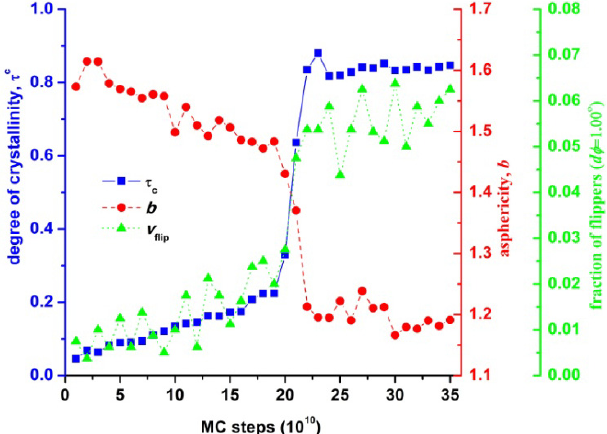
Figure 15. Asphericity, b , averaged over all Voronoi polyhedra, degree of crystallinity, τ c , and fraction of flippers (d ϕ = 1.00°) as a function of MC steps from simulations on the N = 12 chain system with uniform chain length distribution at φ =